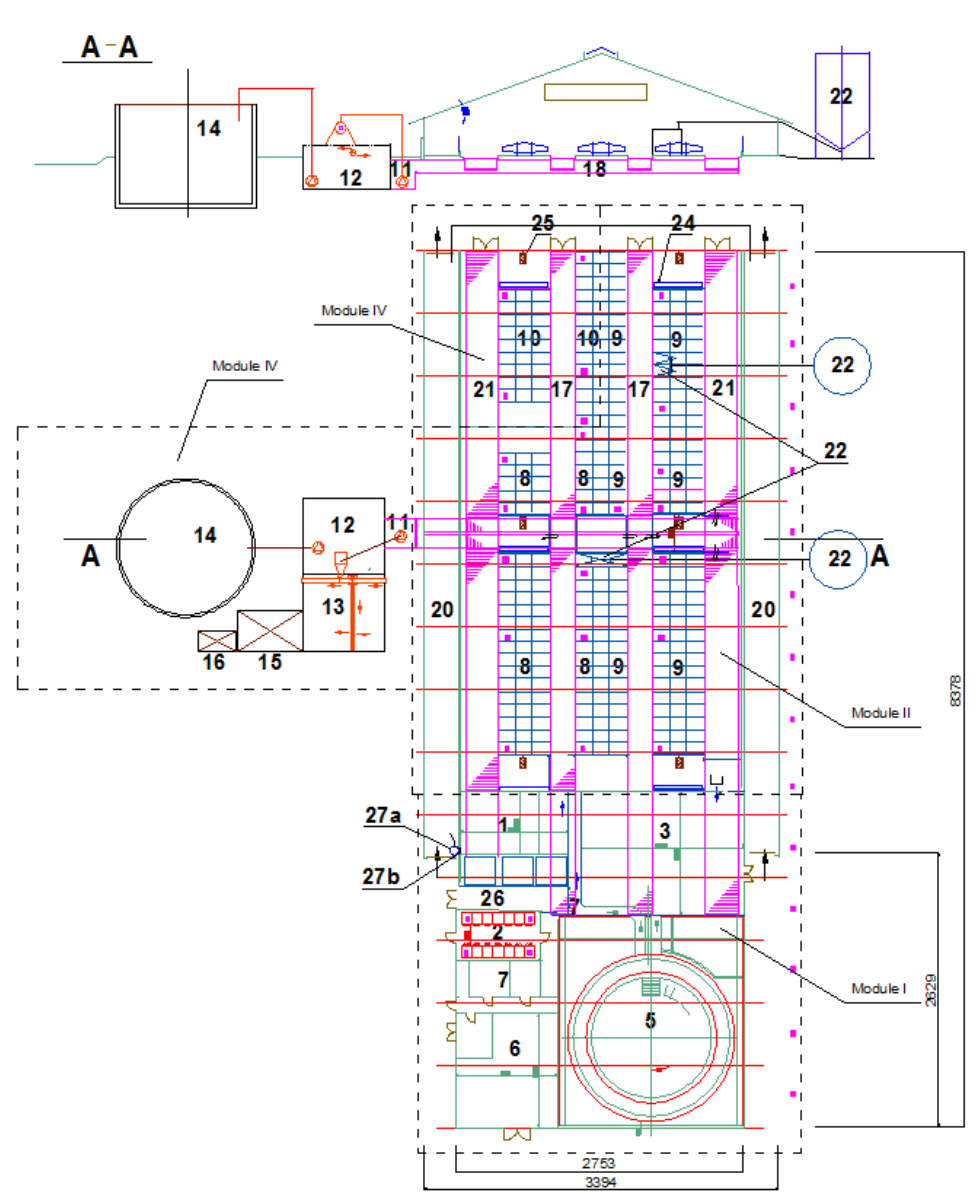
Figure 1. Technological and functional diagram of a free-standing box shed for about 200 dairy cows in the open cycle (own